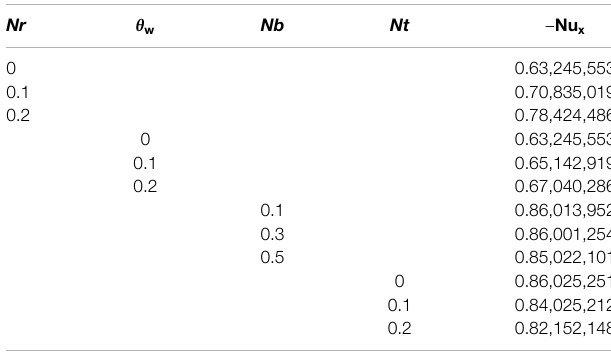
TABLE 3 | Nusselt number against several